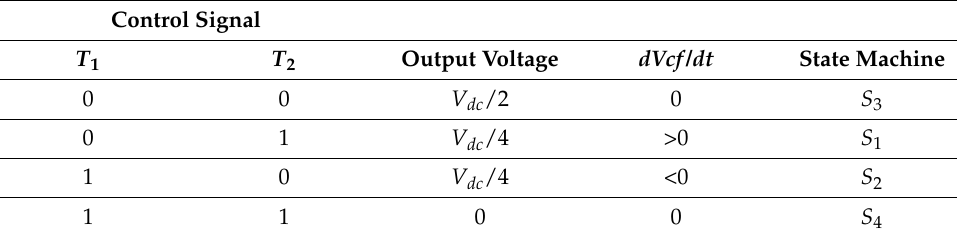
Table 4. Description of the state machine operation for the healthy operation of a five-level VIENNA rectifier for the positive current case.